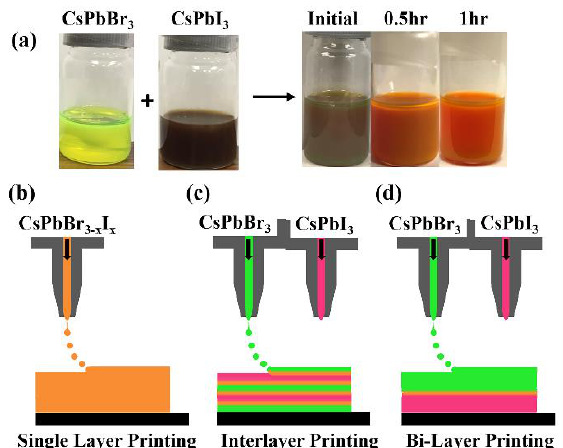
Figure 1. ( a ) (left) the image of pure CsPbBr 3 (yellow) being added to CsPbI 3 (brown) inks (right); these inks are directly alloyed in solution. The schematic of the printing methods employed